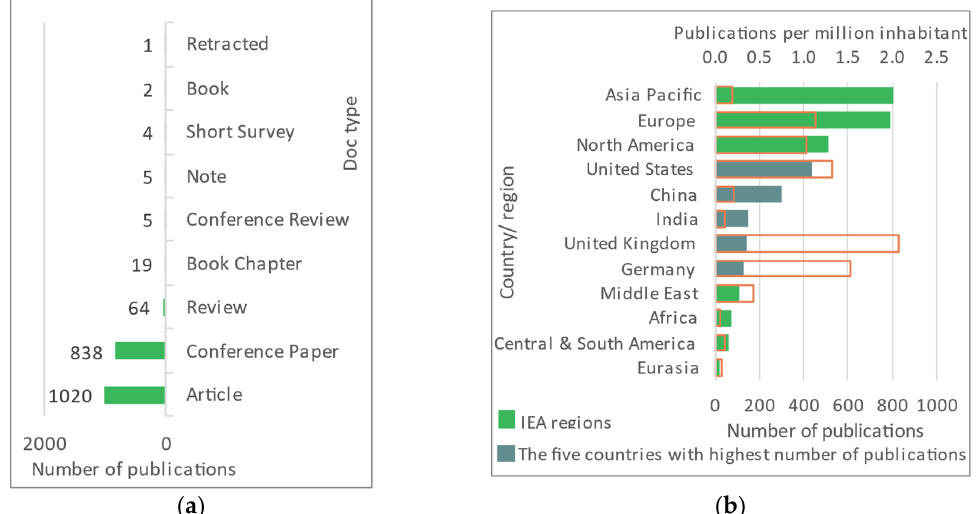
Figure 4. Distribution of documents by ( a ) type of documents ( b ) country/region of publication and in the orange bars publications per million inhabitants.